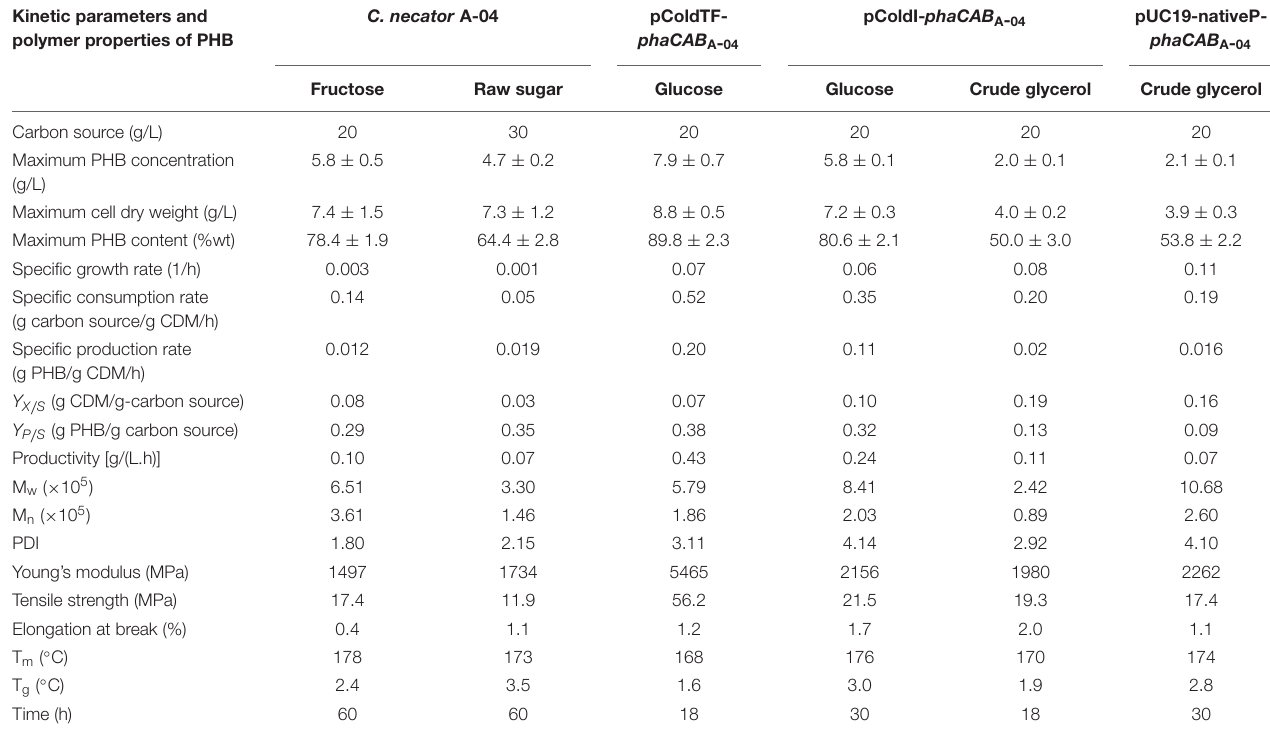
TABLE 5 | Comparison of kinetic parameters, molecular weight, and thermal and mechanical properties of PHB produced by C. necator strain A-04, E. coli JM109 (pColdI- phaCAB Kinetic parameters and polymer properties of